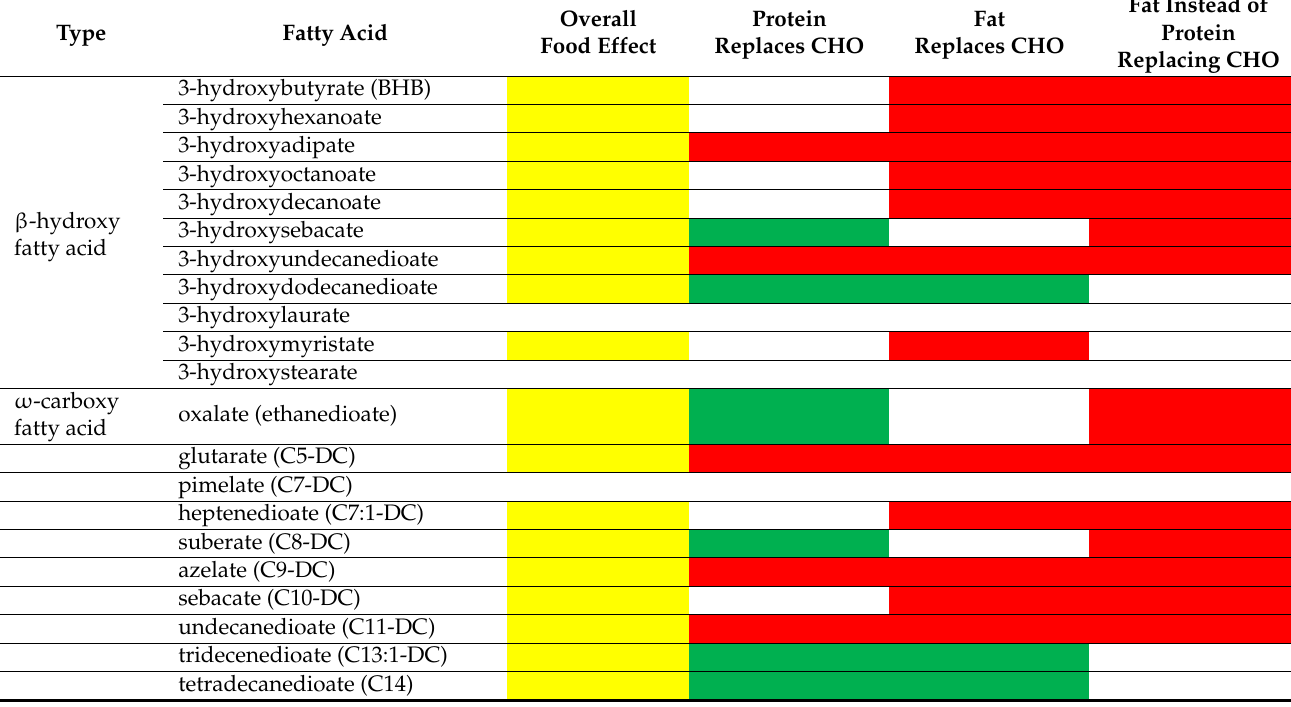
Table 9. Effects of foods on serum β -hydroxy fatty acids and ω − carboxy